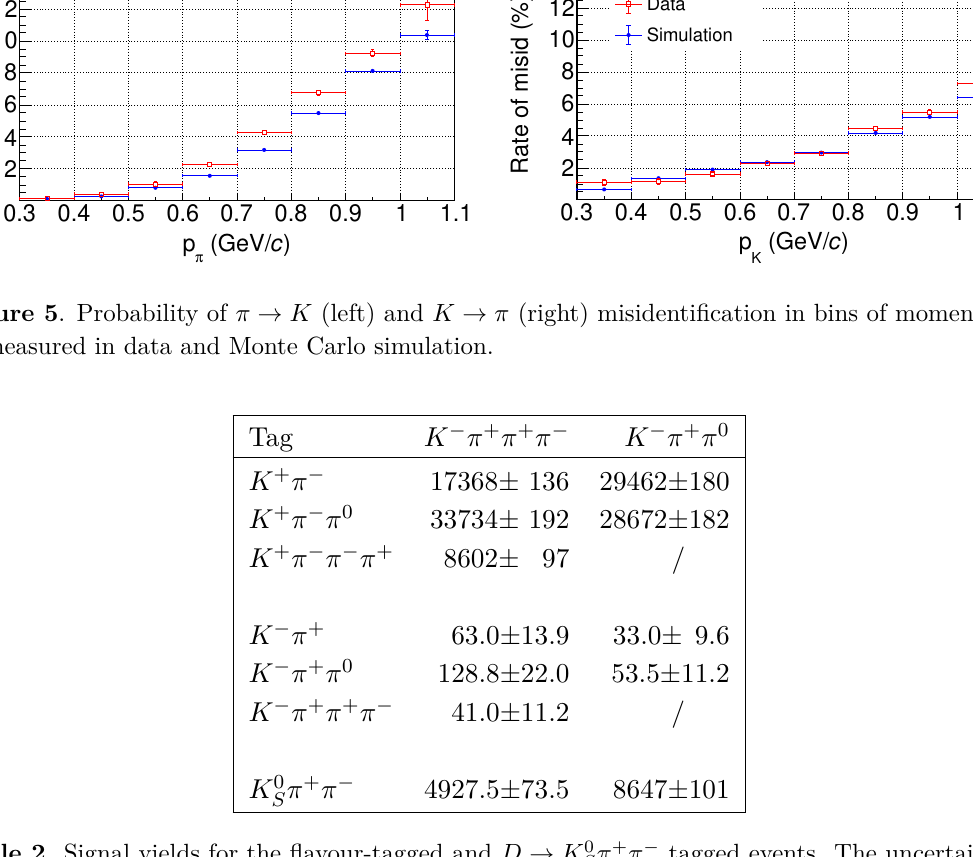
Table 2 . Signal yields for the flavour-tagged and D → K 0 are statistical